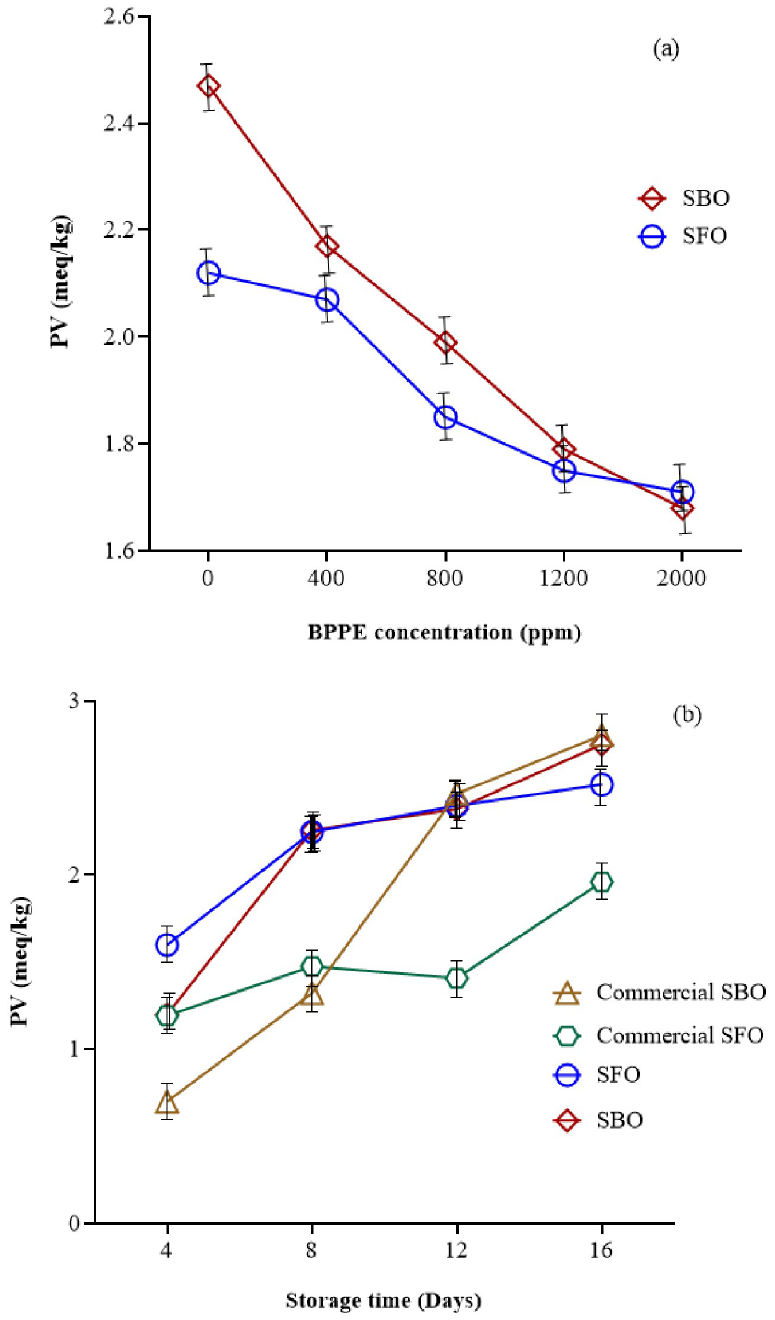
Fig 2. The effect of a) BPPE concentration � and b) storage time � on PV of SBO and SFO. (BPPE: Black plum peel extract, Soy: Soybean oil, Sun: Sunflower oil, CSoy: Commercial soybean oil, CSun: Commercial sunflower oil) � (P �